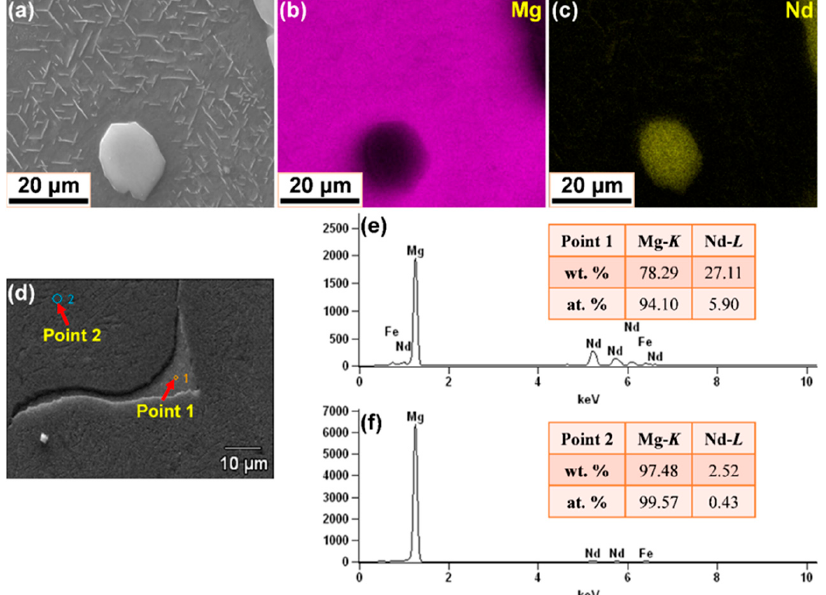
Figure 5. Micrographs and chemical composition analysis of Mg–3Nd alloy: ( a – c ) BSE image and corresponding elemental mappings; ( d – f ) SEM image and point EDS results of the secondary phase and Mg matrix.